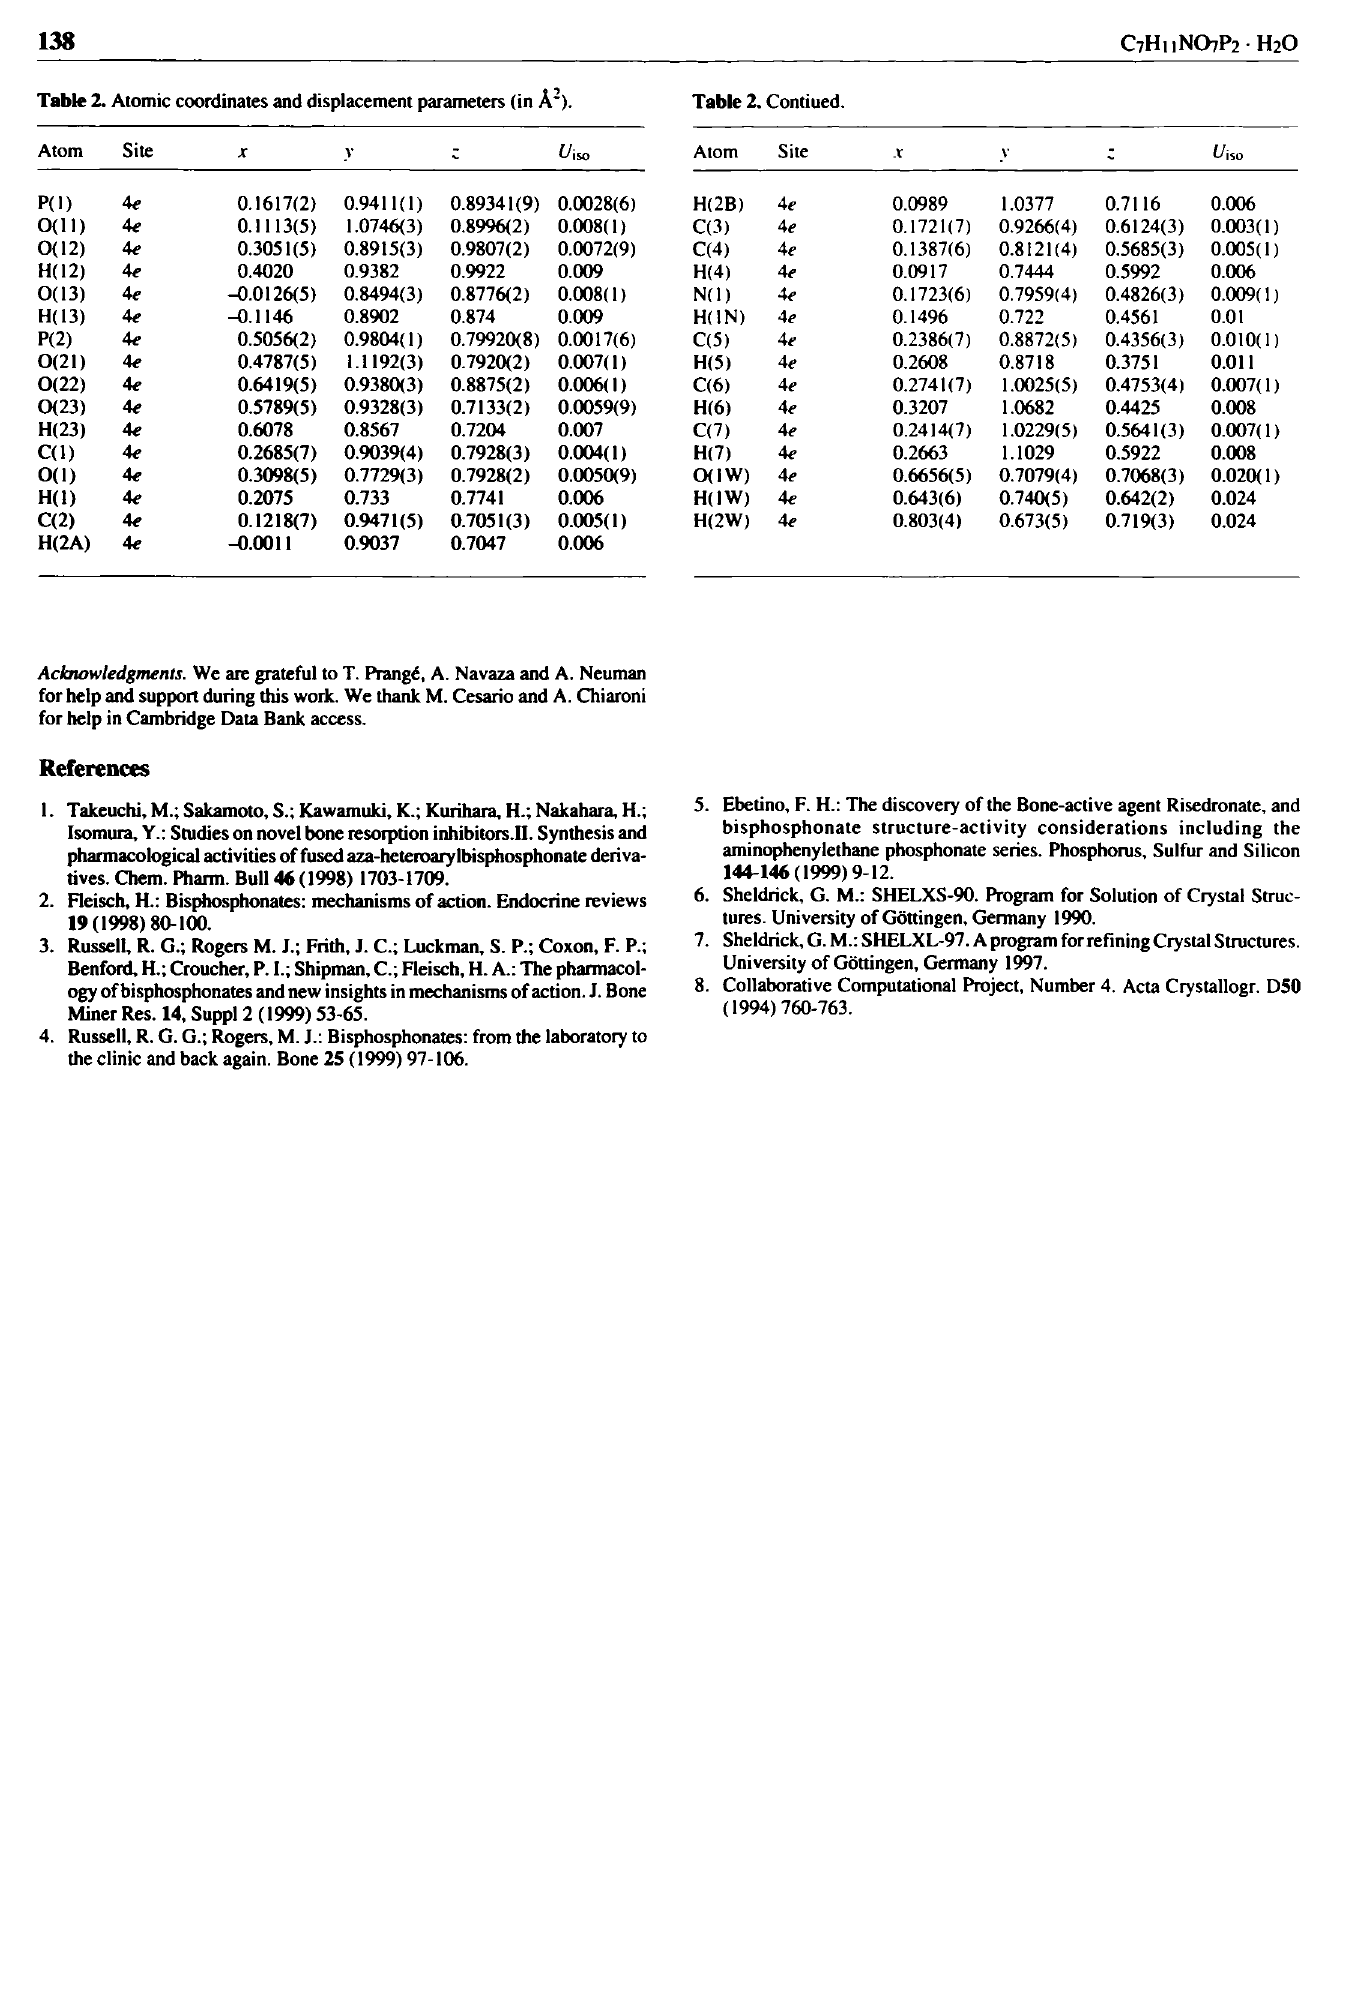
Table 2. Atomic coordinates and displacement parameters (in Â 2 ). Table 2.